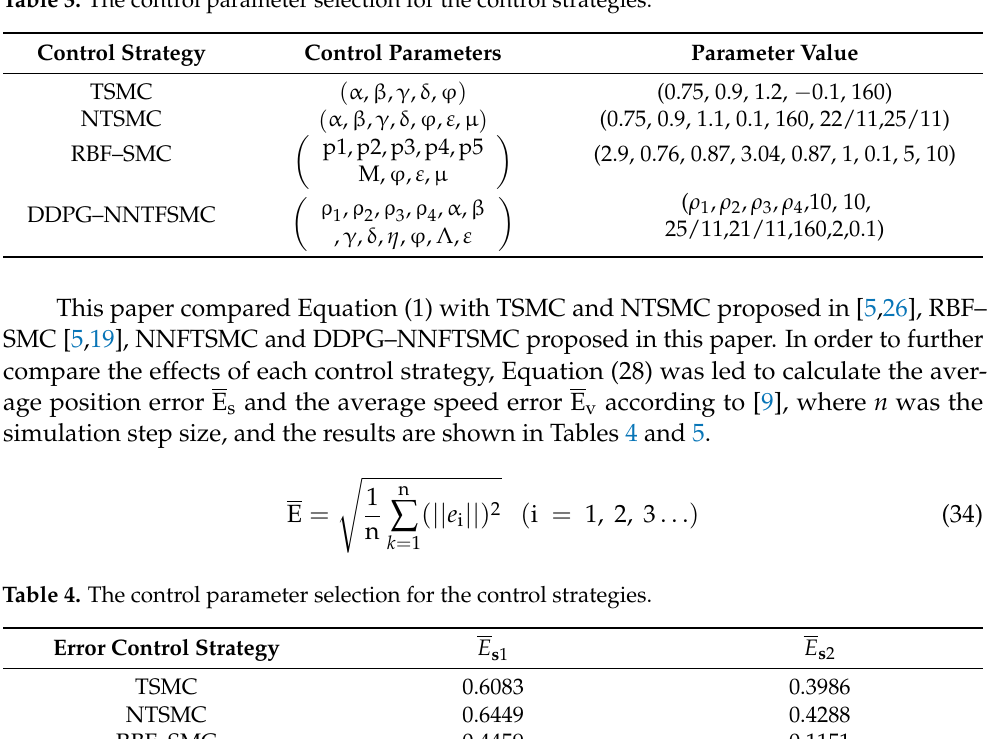
Table 3. The control parameter selection for the control strategies.